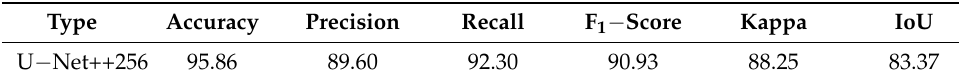
Table 5. Performance of U − Net++ in the Bijie landslide dataset.